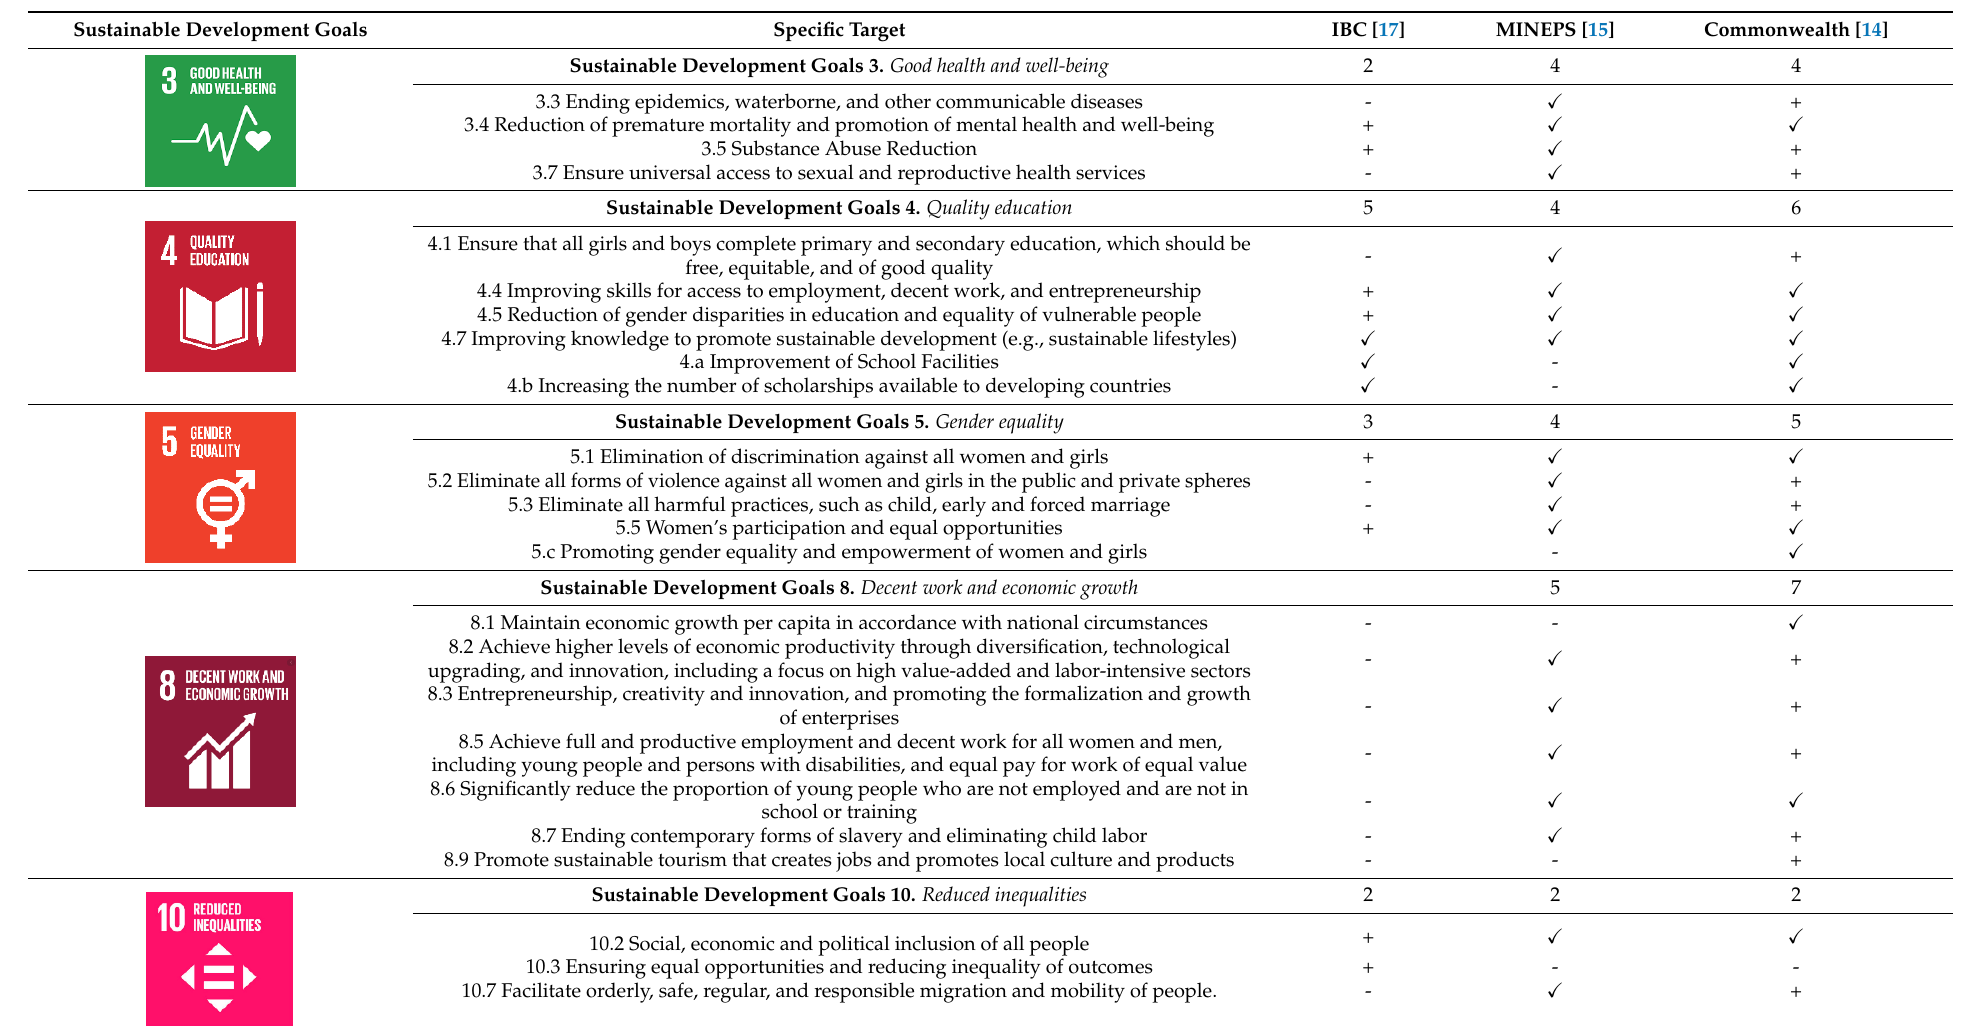
Table 1. Relationship of Physical Education, Sport and Physical Activity with Sustainable Development Goals and their specific targets according to institutional analysis.